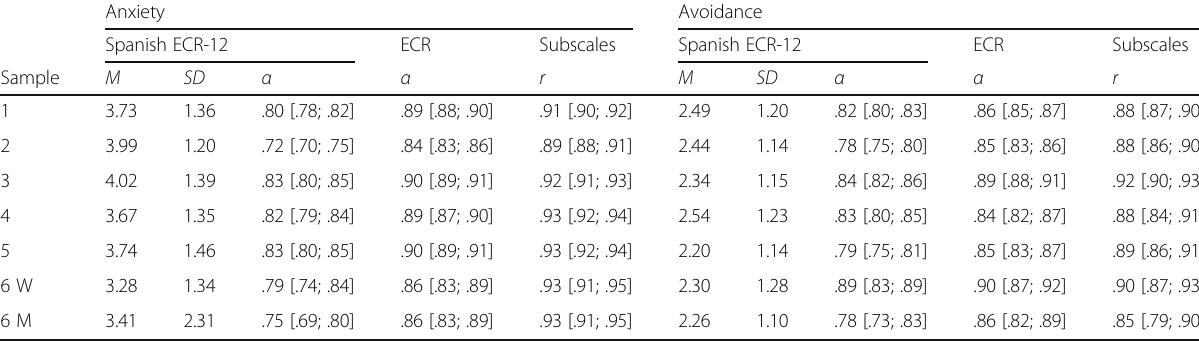
Table 5 Means, standard deviations, and Cronbach ’ s alpha and correlation coefficients with 95% confidence intervals for ECR anxiety and avoidance